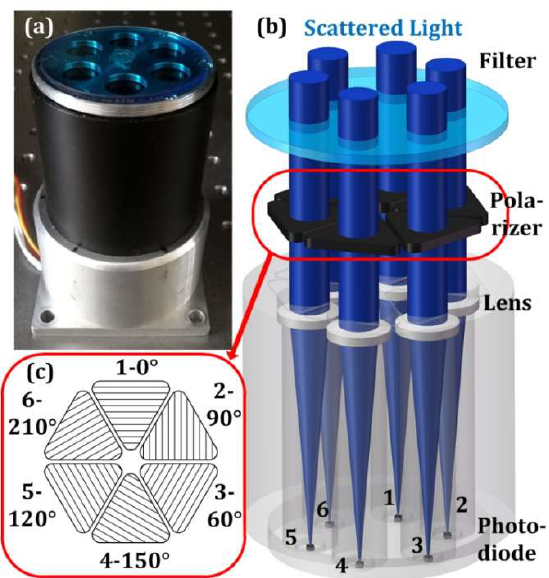
Figure 1. Photograph and schematic of bio-inspired polarization sensor. ( a ) Photograph of sensor; ( b ) light path of scattered light; ( c ) directions of the six polarizers.